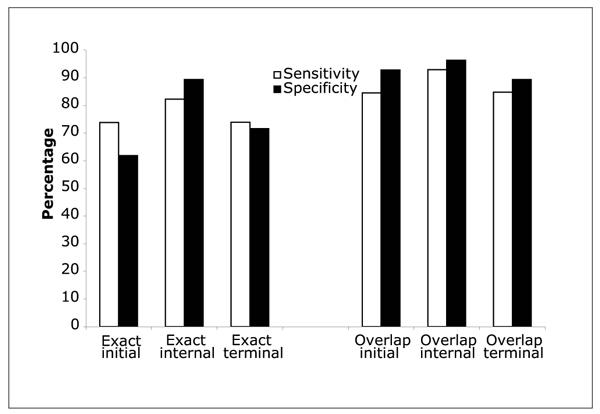
GENCODE and Exogean agree more often on exact boundaries of internal rather than external exons. Histogram of Exogean sensitivity and specificity in identifying the exact boundaries (left) and overlapping boundaries (right) of Havana initial, internal and terminal exons. While Exogean more or less predicts overlapping exons with similar specificities for initial, internal and terminal exons, this is not the case for exactly matching exons: Exogean internal exons are much more specific (89%) than external ones (62% and 72%).